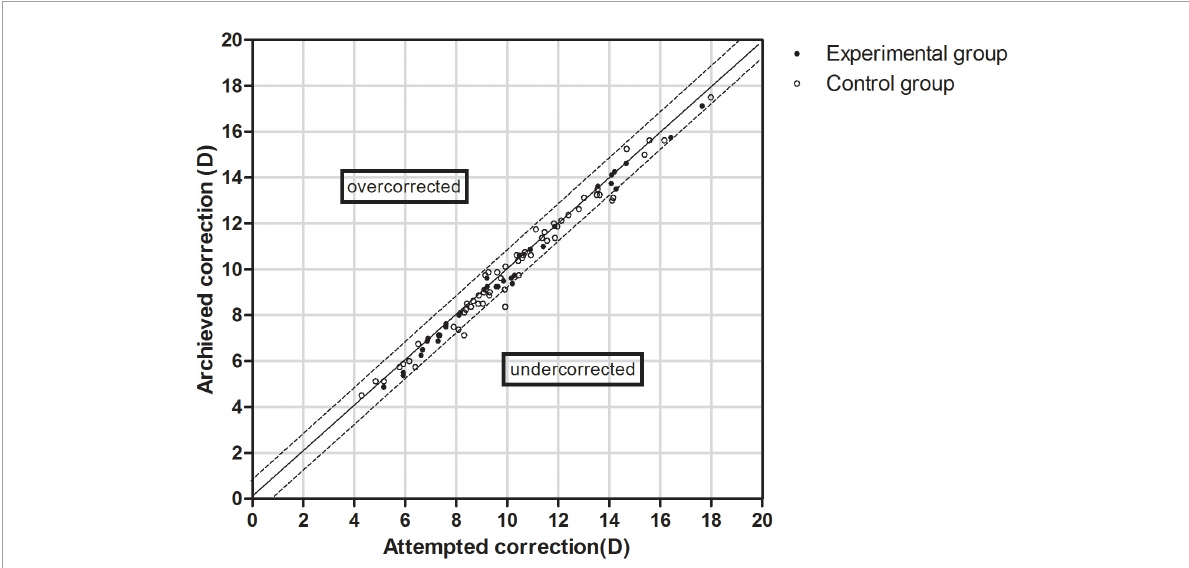
FIGURE3 Scatter plot of attempted versus achieved correction (spherical equivalent) after EVO Implantable Collamer Lens implantation between experimental and control groups. The black solid line represented achieved correction = attempted correction, the black dotted line represented achieved correction = attempted correction ± 1.00 D.